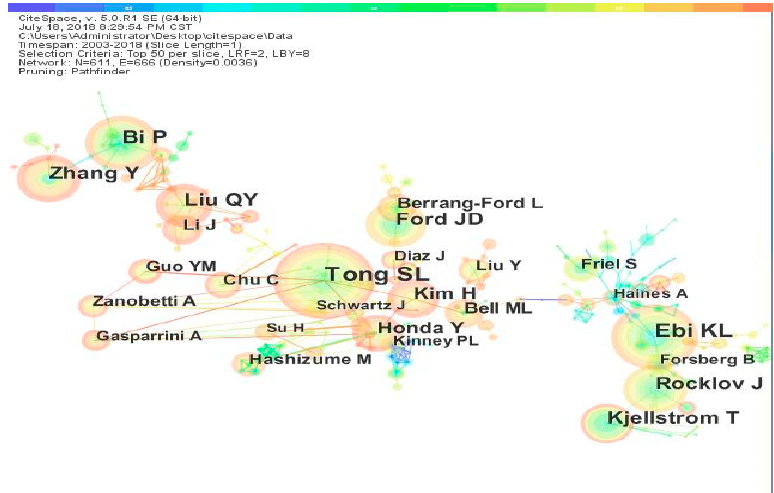
Figure 6. Co-author network.